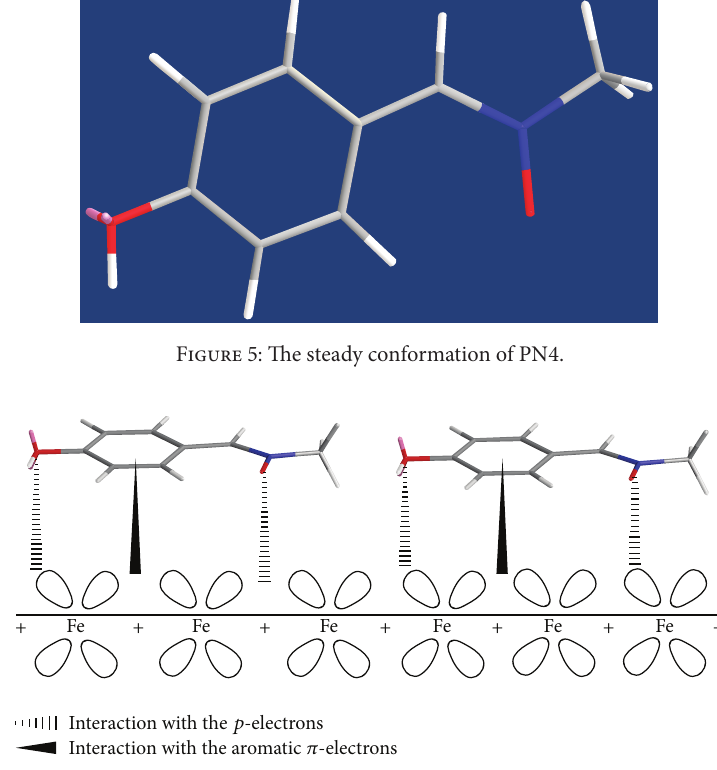
Figure 6: The absorption of PN4 on the steel surface by coordination.